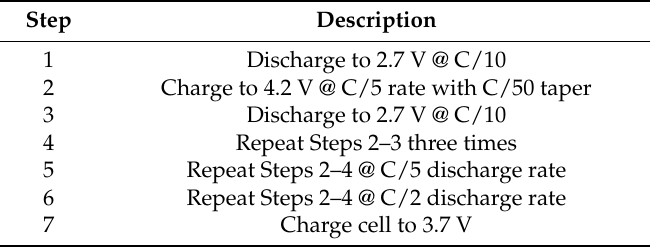
Table 2. Test procedure for protected 18650 cells. 3-min rest following all charge and discharge steps. Step